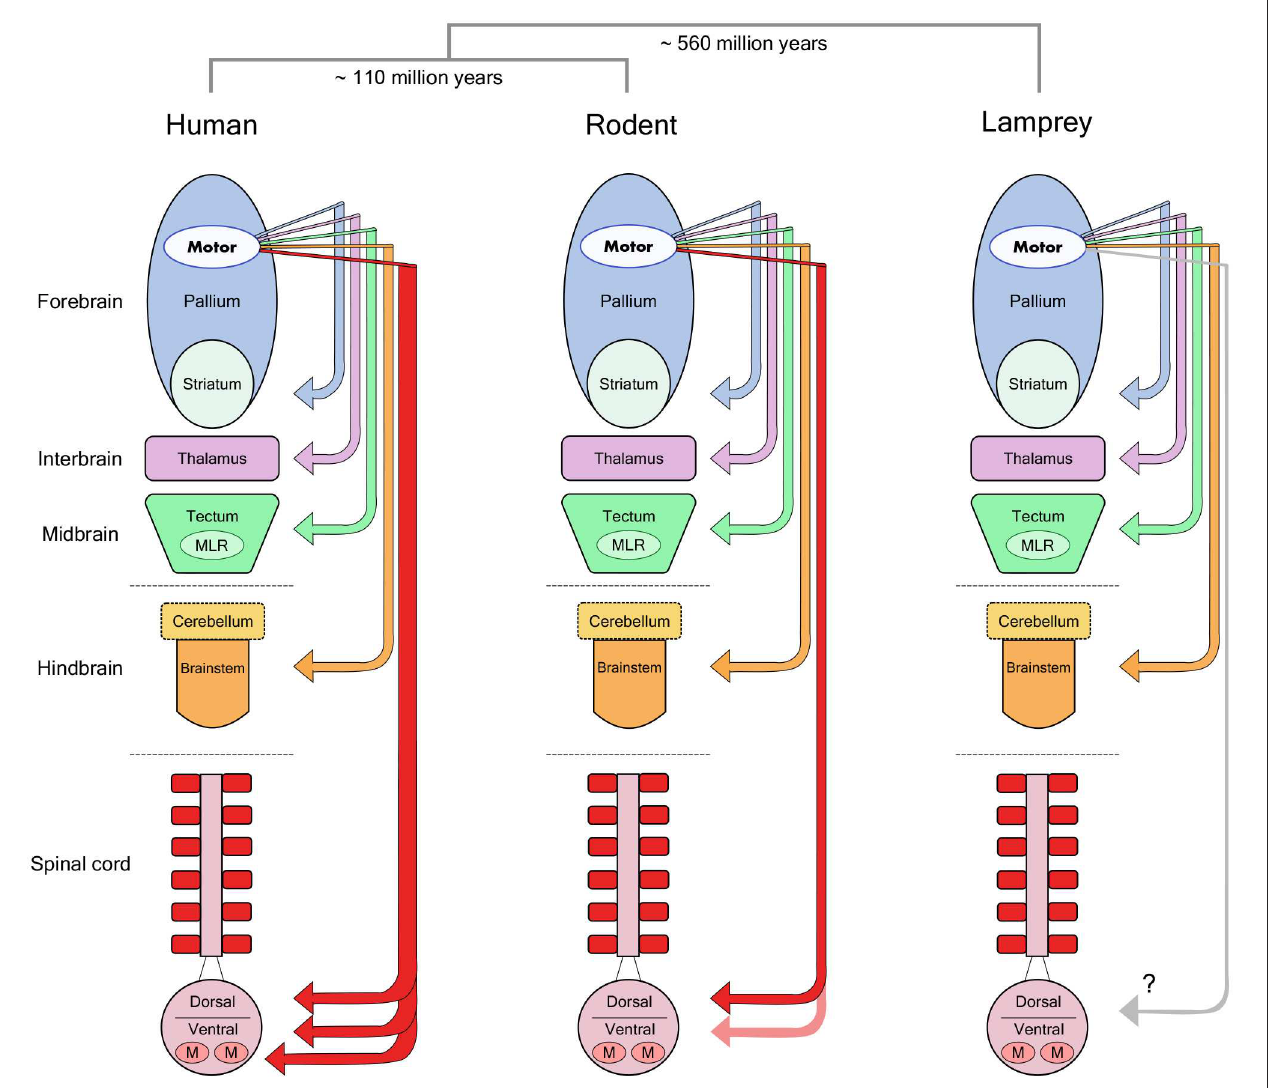
FIGURE1 Forebrain motor control pathways across different vertebrate taxa. The molecular divergence times between human (primate), rodent and lamprey groups (Kumar and Hedges, 1998) are noted above a schematic view of the major divisions in the vertebrate brain. Arrows indicate the descending monosynaptic projections identified in each group from motor regions of the forebrain pallium to lower motor centers. Note the specialized monosynaptic projection directly targeting spinal motor neurons in human. MLR, Mesencephalic Locomotor Region; M, Motor Neurons. Reproduced from Lopes and Kampff